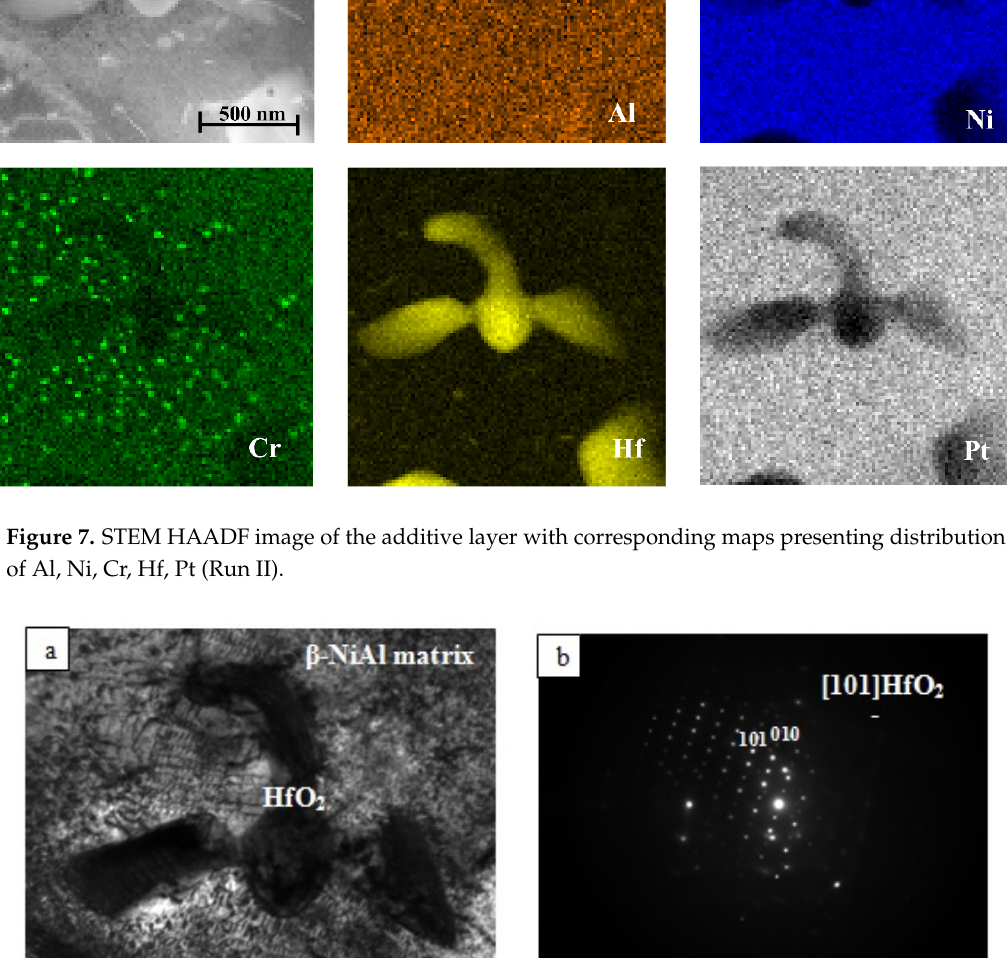
Figure 8. TEM image of the hafnium-rich particle ( a ) with accompanying diffraction ( b ) and ( c ) energy dispersive spectroscope (EDS) spectra. 4. Conclusions The SEM/TEM investigation of the microstructure and phase composition of hafnium and platinum co-doped aluminide coating deposited on Inconel 625 alloy proved that: 1.